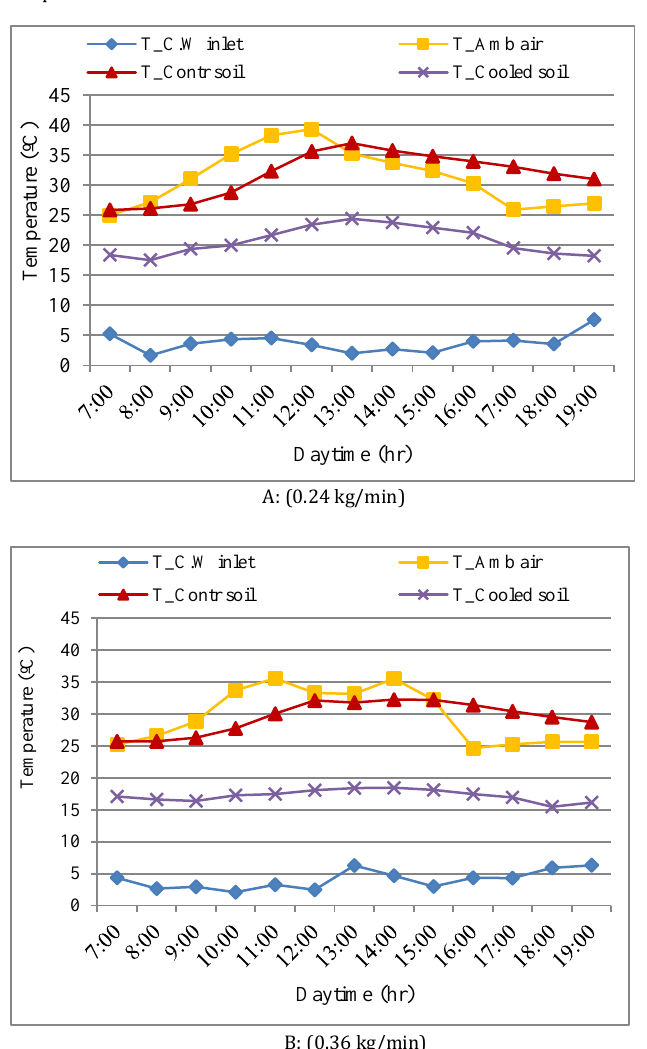
be required at night-time to save pumping